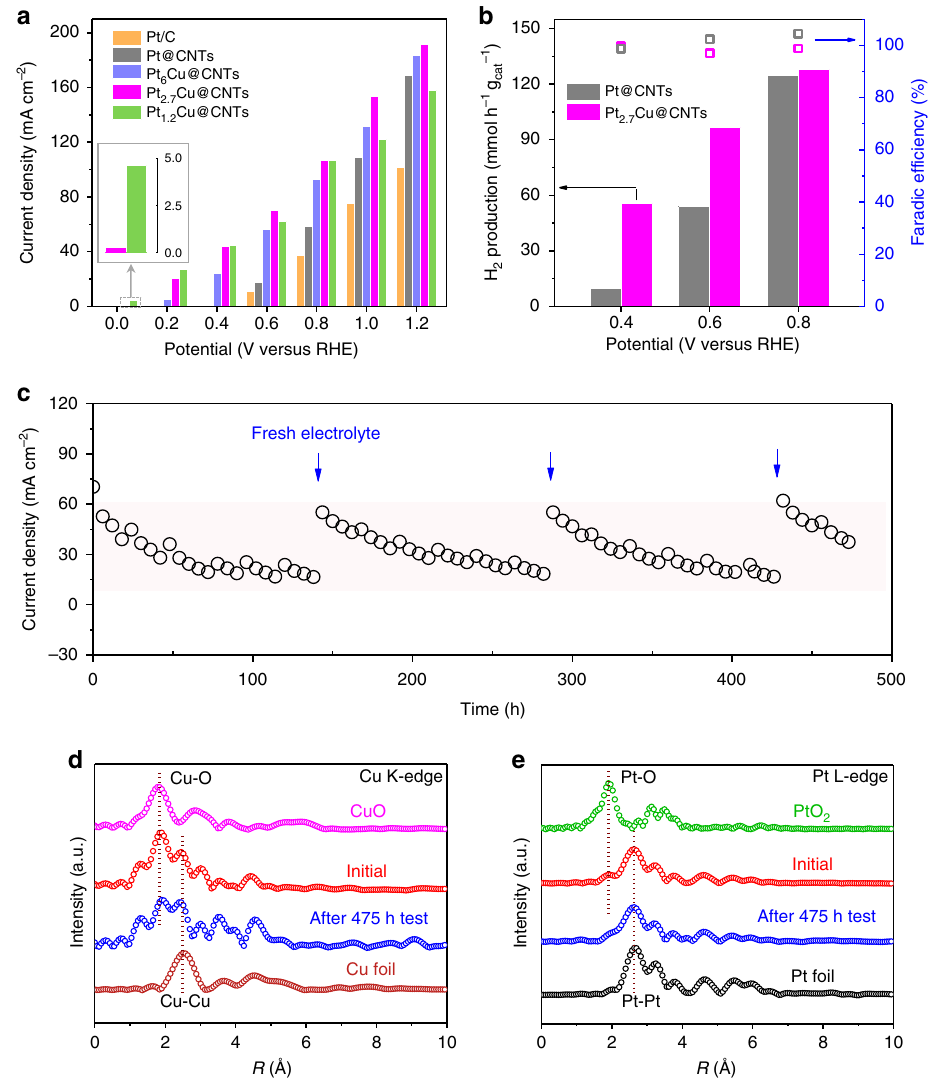
Fig. 4 Activity and stability of the PtCu@CNTs anode catalysts for the EWGS. a The current density of CO oxidation on the Pt/C, Pt@CNTs, and PtCu@CNTs at different potentials. Inset shows that the current density at 0 V versus RHE reaches 0.2 and 4.6 mA cm − 2 for Pt 2.7 Cu@CNTs and Pt 1.2 Cu@CNTs, respectively. b The rate of H 2 production and faradaic ef fi ciency on the cathode at different potentials with the Pt 2.7 Cu@CNTs and Pt@CNTs as the anode catalysts. c Durability test of the Pt 2.7 Cu@CNTs at a constant potential of 0.6 V versus RHE. The blue arrows denote the time